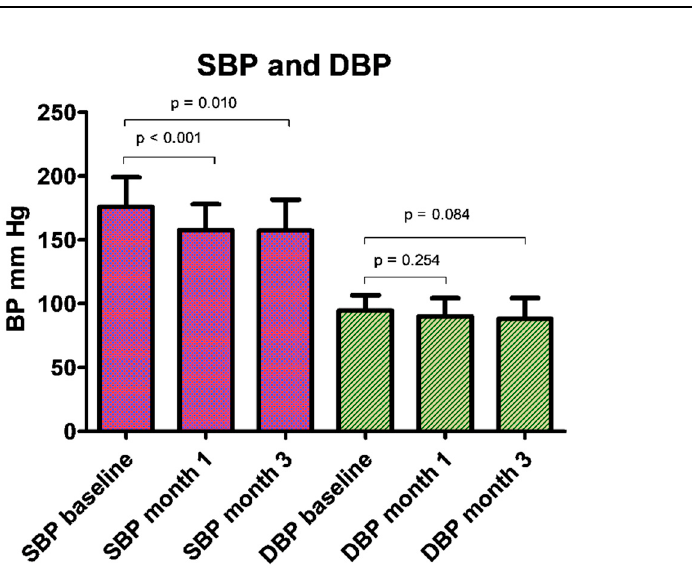
Figure 1. Effects of renal sympathetic denervation on office BP measured after 3 min of rest at baseline and at 1 and 3 months’ follow-up. Differences measured by t -test.